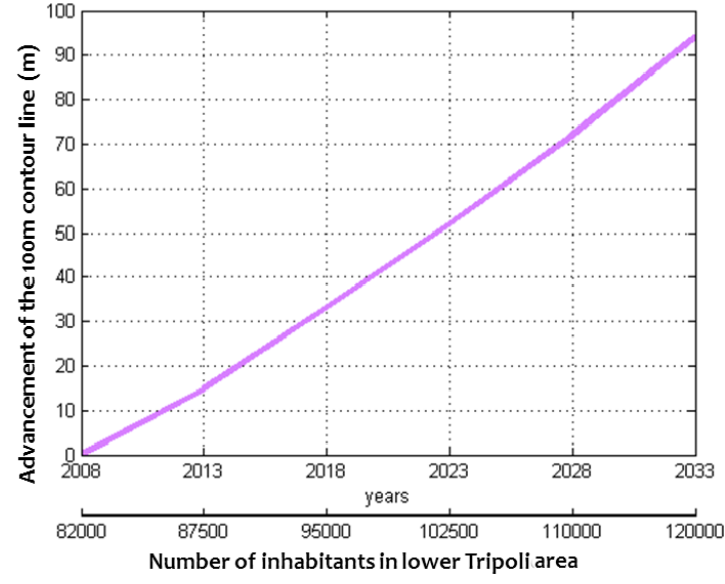
Figure 12. Advancement in-land of the 100 m contour line of the seawater freshwater interface with respect to demographic